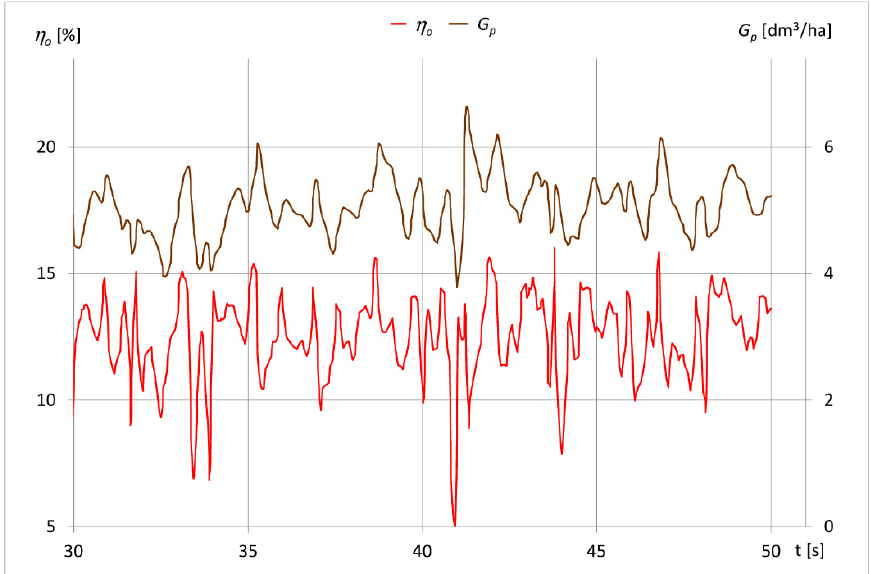
Figure 13. Changes in total efficiency η o of the tractor unit and fuel consumption per hectare G p in the first gear, soil profile—medium clay, and depth setting a nS 2 = 0.19 m.